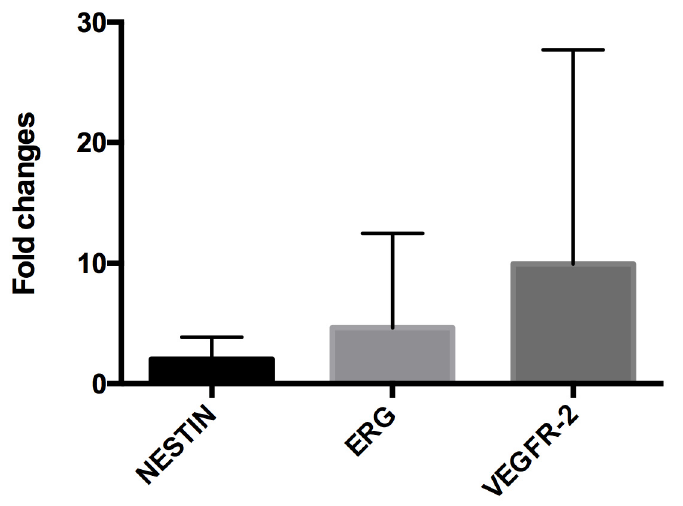
Figure 3. At RT-PCR analysis the mean fold increase from allocation biopsies to post-perfusion biopsies for was 2.04 for Nestin, 4.63 for ERG, and 9.95 for VEGFR-2. biopsies for was 2.04 for Nestin, 4.63 for ERG, and 9.95 for VEGFR-2. Table 2. General, immunohistochemical and main follow-up of the patients enrolled in the HOPE and static cold storage (SCS) groups. * Chi-square test. HOPE (n = 34) SCS (n = 13)